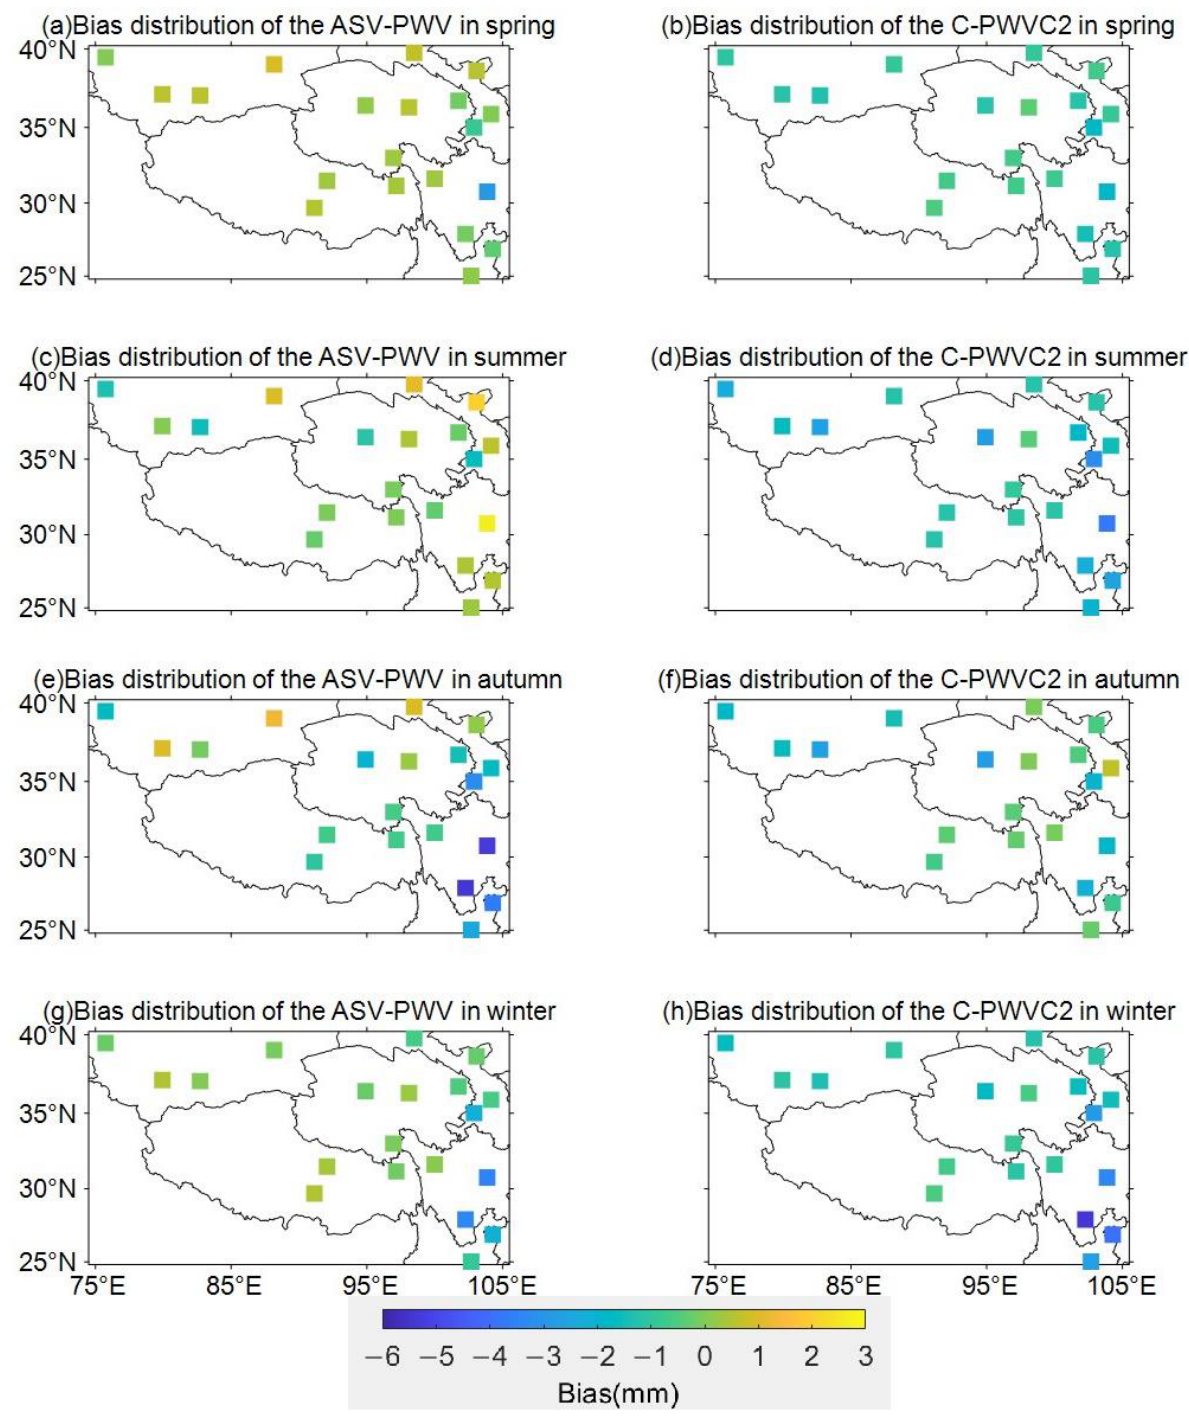
Figure 7. Bias distribution of the ASV-PWV and C-PWVC2 in 4 seasons of